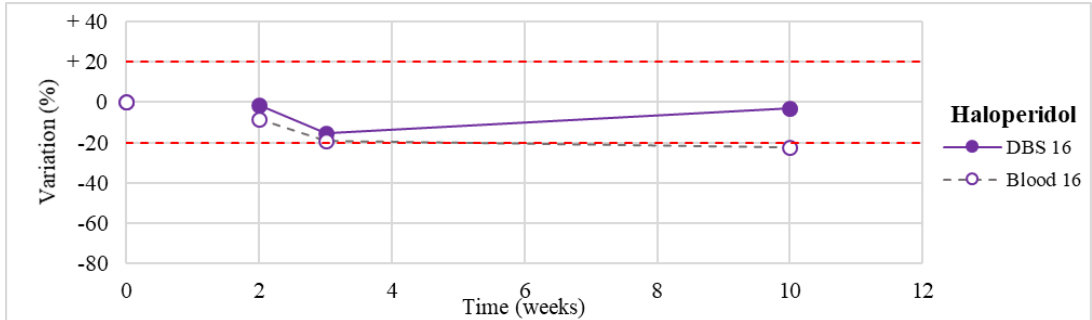
Figure 15. Long-term stability of dixyrazine ( n = 1) in DBSs stored at room temperature and in blood stored at −20 °C.